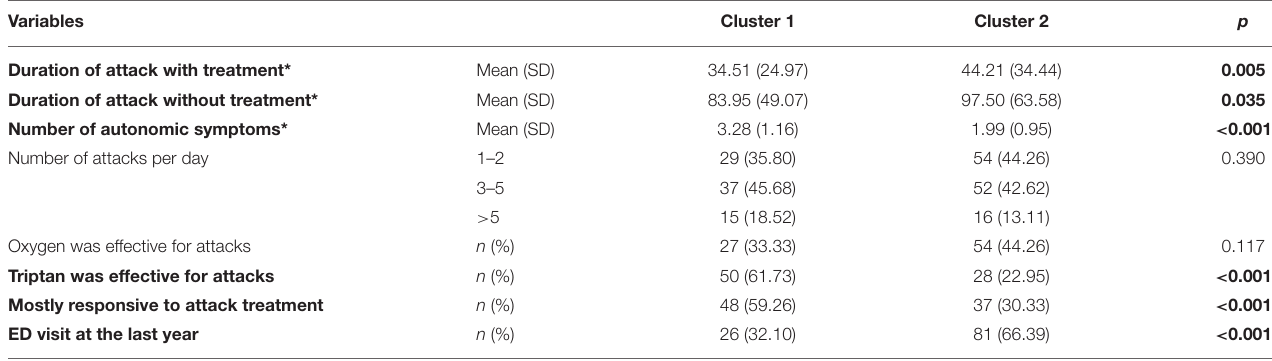
TABLE 3 | Clinical features and treatment experiences of the patients in cluster analysis.